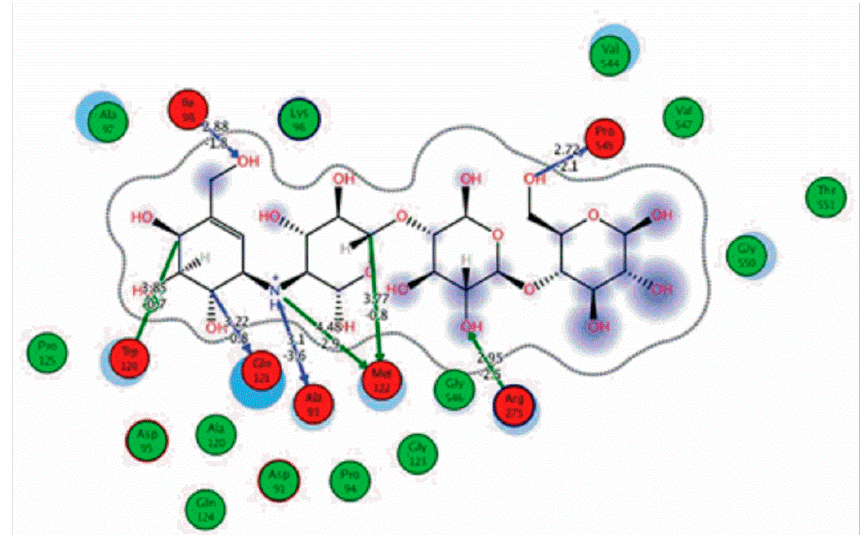
Figure 9. 2D interactions of standard (acarbose). Acarbose showed seven hydrogen, Ala93, Ile98,